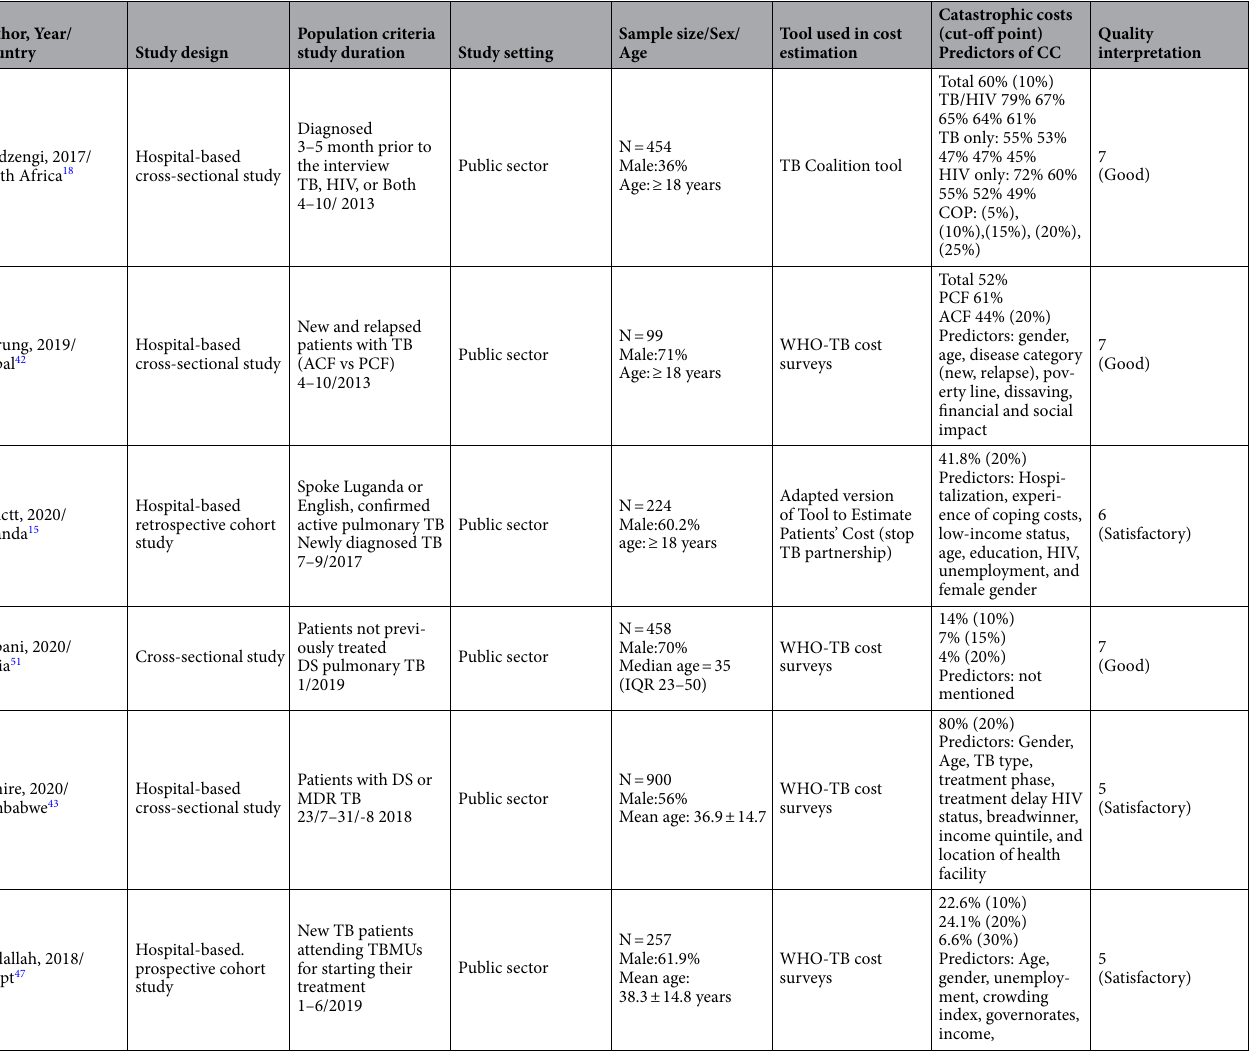
Table 1. Studies that addressed catastrophic costs included in systematic review analysis. ACF Active case finding, PCF Passive case finding, SP Smear Positive, TB Tuberculosis, DS Drug sensitive, HIV Human